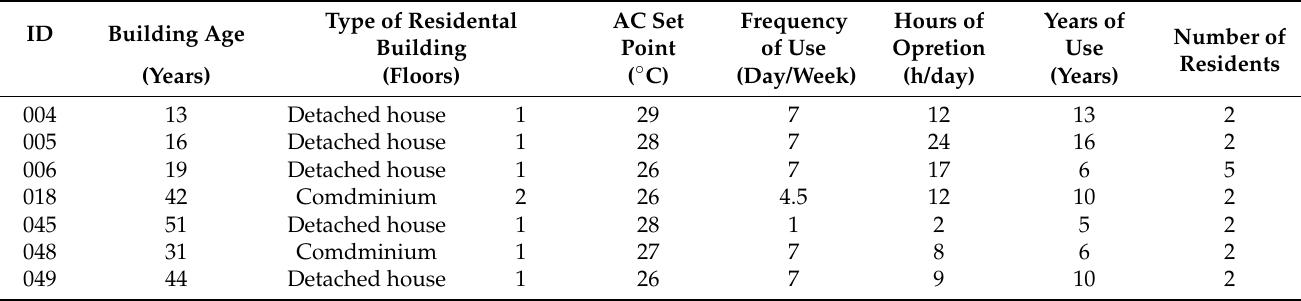
Table 1. Information on the measured residential buildings and room air